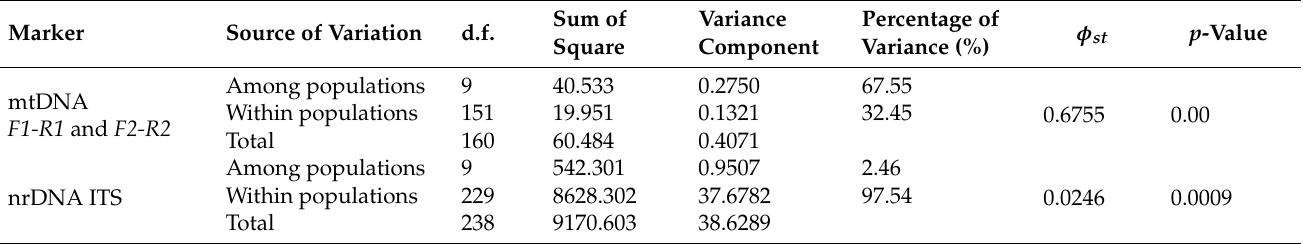
Table 3. Analysis of molecular variance (AMOVA) of both mtDNA and nrDNA ITS markers of N. cadamba .